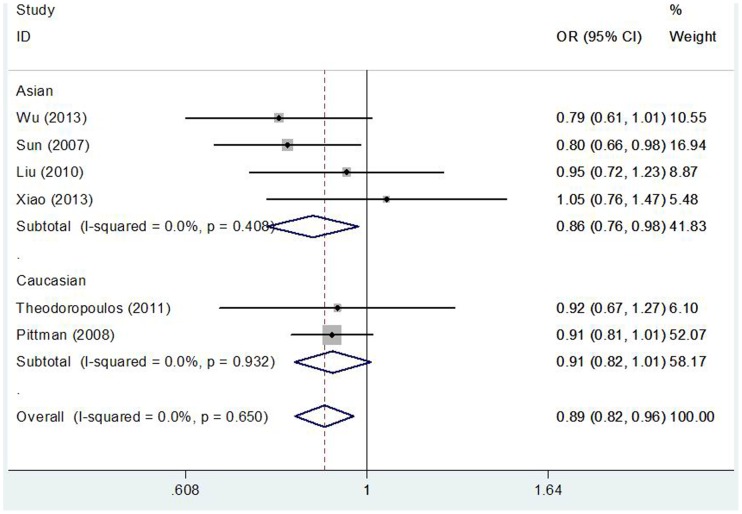
Forest plot of the CASP8 −652 6N del polymorphism and CRC risk using a fixed-effect model (dominant model del/del + ins/del vs. ins/ins).